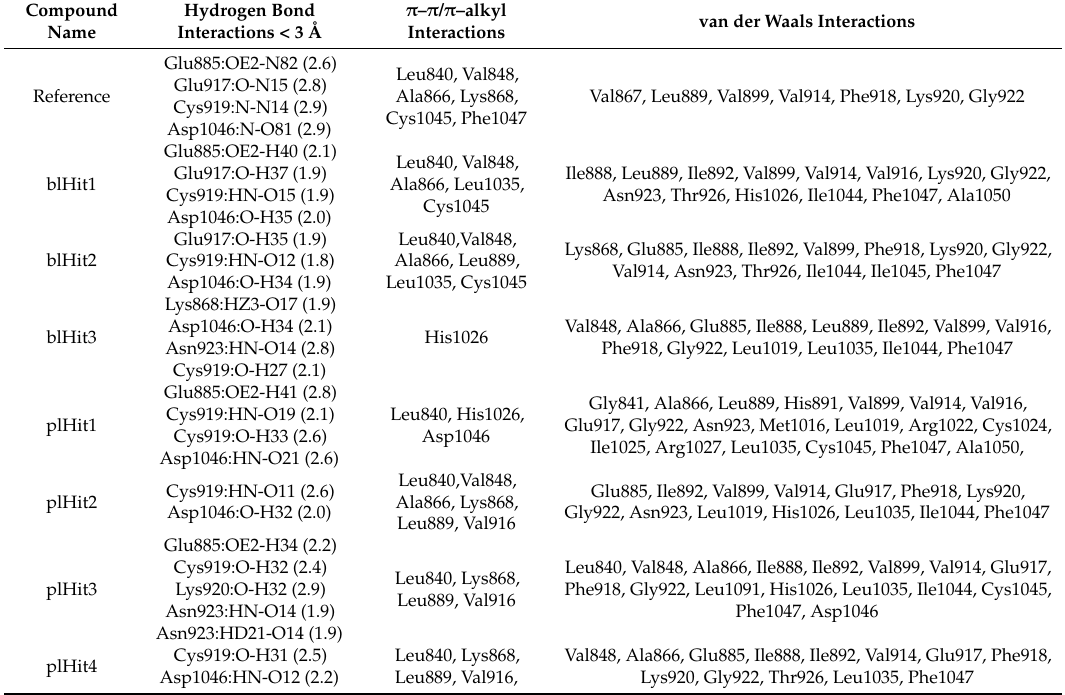
Table 3. Tabulation of different interactions prompted by protein-hit